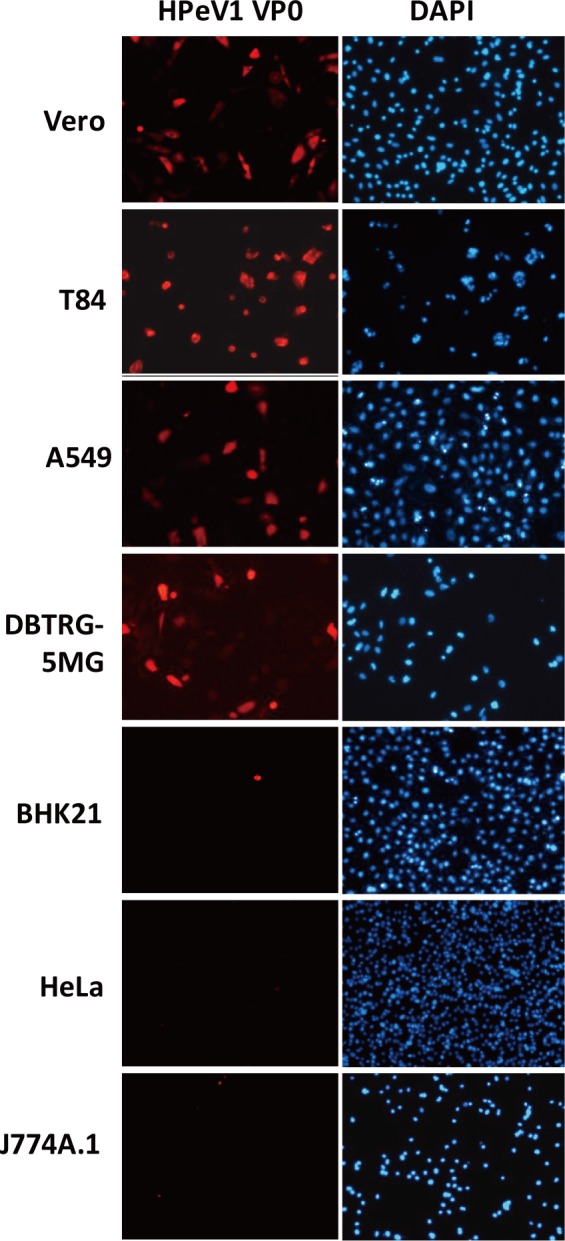
Cell tropism of HPeV1.Vero, T84, A549, DBTRG-5MG, BHK21, HeLa and J774A.1 cells at
2×105 were infected with HPeV1 for 6 h at
multiplicity of infection (MOI) = 1; HPeV1 VP0 was detected by
immunofluorescence assay with anti-VP0 antibody; images show the red
fluorescence of VP0 staining in susceptible cell types. DAPI staining
indicated cell nucleus.